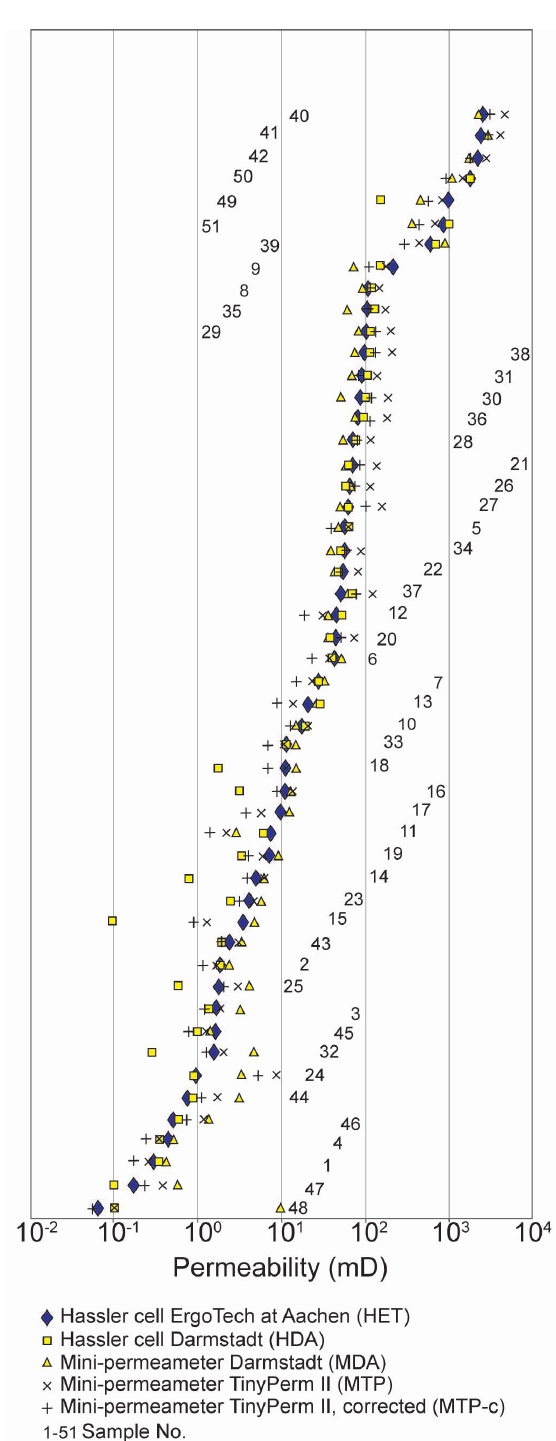
Fig. 4. Permeability data derived from 51 core plug samples, mea- sured with four different air permeameters: the Hassler cells of the ErgoTech gas permeameter (HET, blue diamonds) and the gas permeameter in Darmstadt (HDA, yellow squares), and the minipermeameters Miniperm Darmstadt (MDA, yellow triangles) and TinyPerm II (MTP,